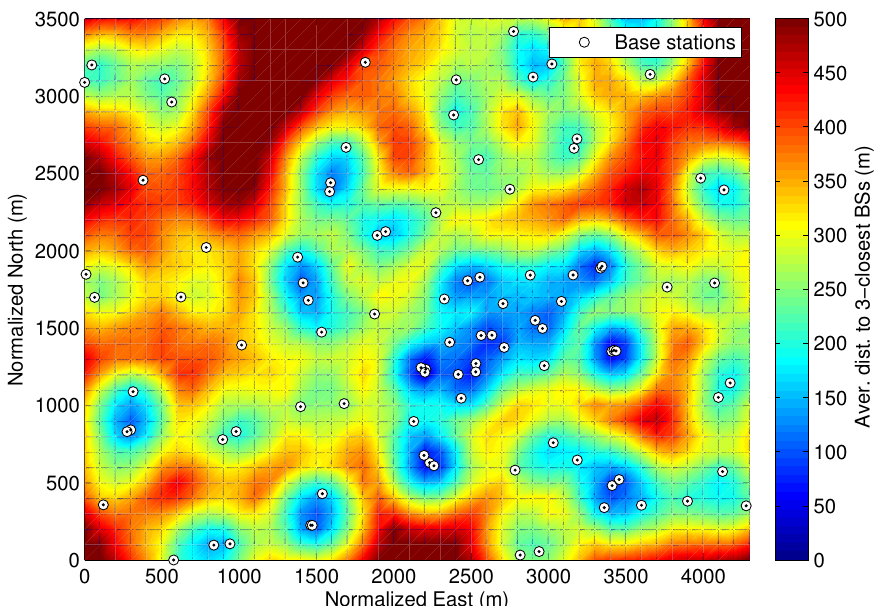
Figure 1. Average distance to the three closest BSs of a representative LTE network deployment.